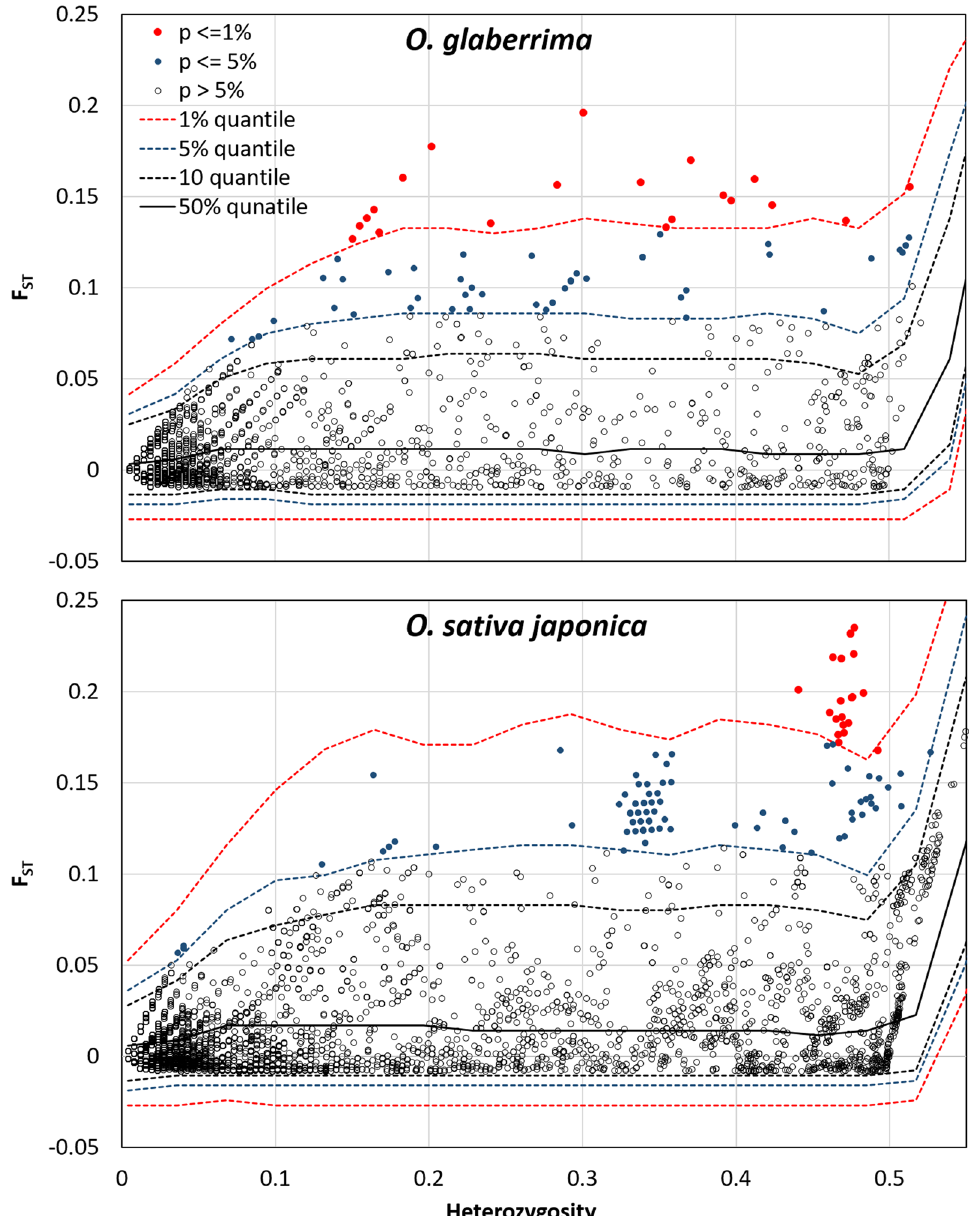
Fig. 6 Plot of the joint distribution of F ST and heterozygosity within populations for the observed loci (circles) and the one-sided confidence interval limits obtained from simulated data (dashed lines). Loci departing from neutrality hypothesis at 1% and 5% significance levels are indicated in red and blue circles, respectively. The number of observed loci was 6250 for O. glaberrima , 9282 for O. sativa